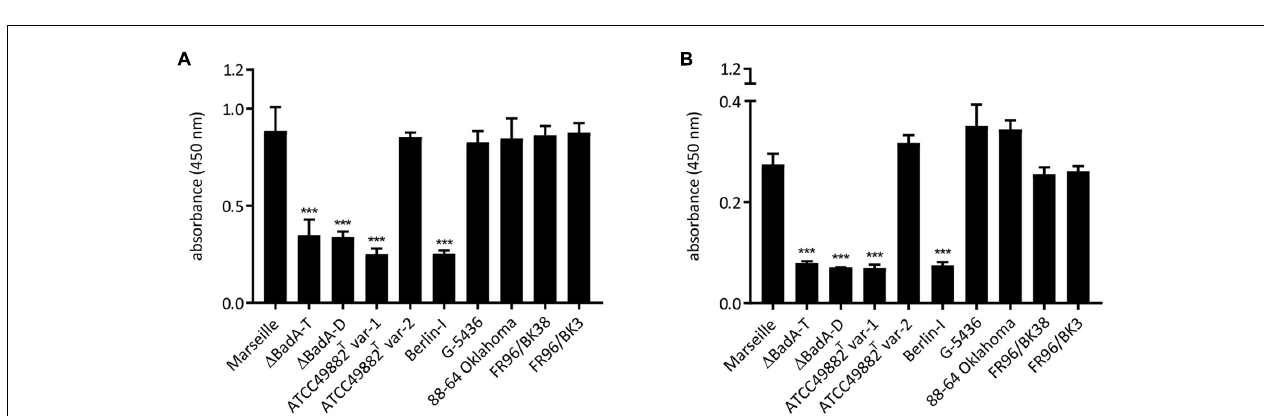
FIGURE 7 | Adhesion of B. henselae strains to extracellular matrix proteins. Binding of the various B. henselae strains to (A) human plasma Fn and (B) human Col-I. Wells were coated with Fn and Col-I and adherent bacteria were quantified via whole cell ELISA (see section “Materials and Methods”). BadA-expressing strains show a significantly higher binding to human plasma Fn and human Col-I compared to strains lacking BadA expression. Statistical significance was determined using one-way ANOVA testing (*** p <